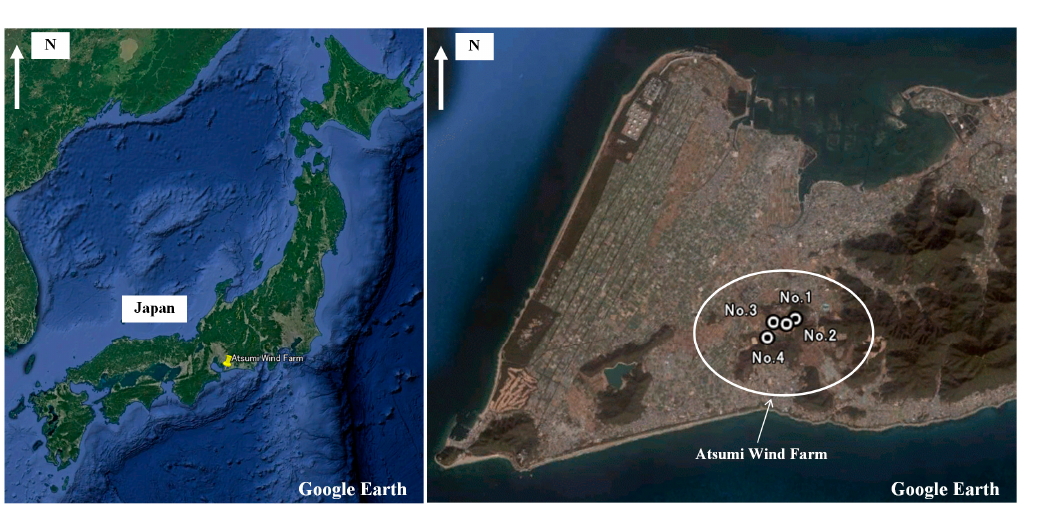
Figure 1. Terrain at and in the vicinity of the Atsumi wind farm, Aichi Prefecture, Japan.